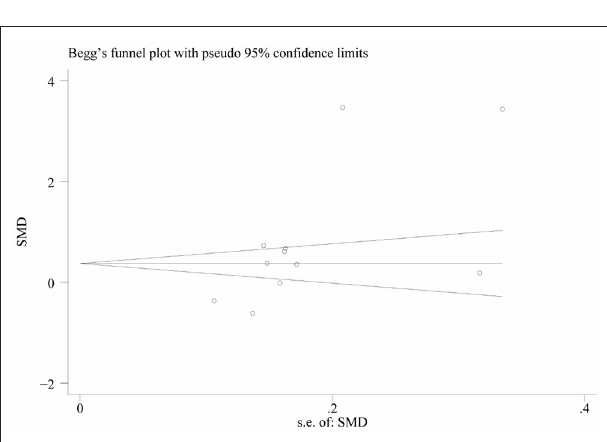
FIGURE 3 | Funnel plot of standard mean difference (SMD) in serum uric acid level between the BPPV and control groups.